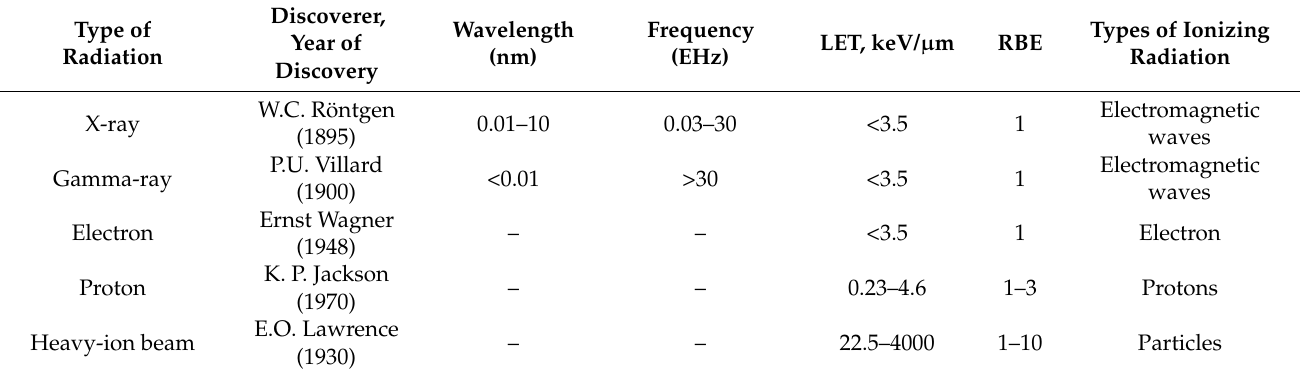
Table 1. Main types of ionizing radiation and their characteristics.